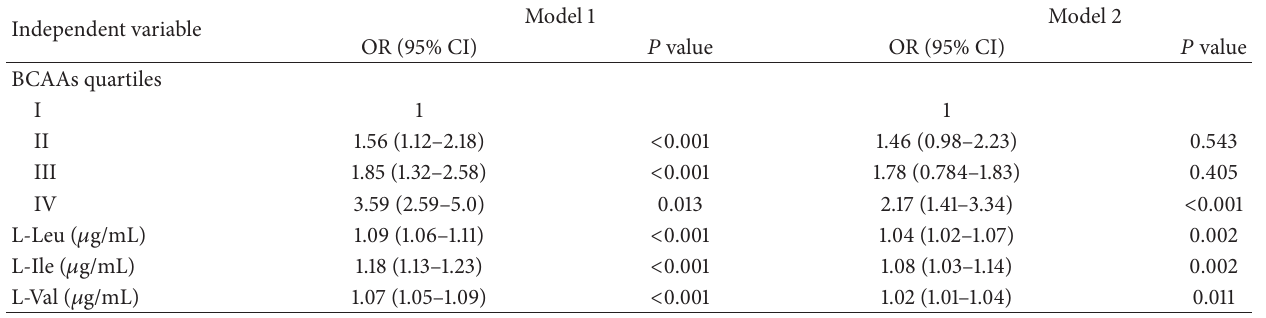
Table 3: Multiple logistic regression analyses of the relationship between BCAAs and MS.